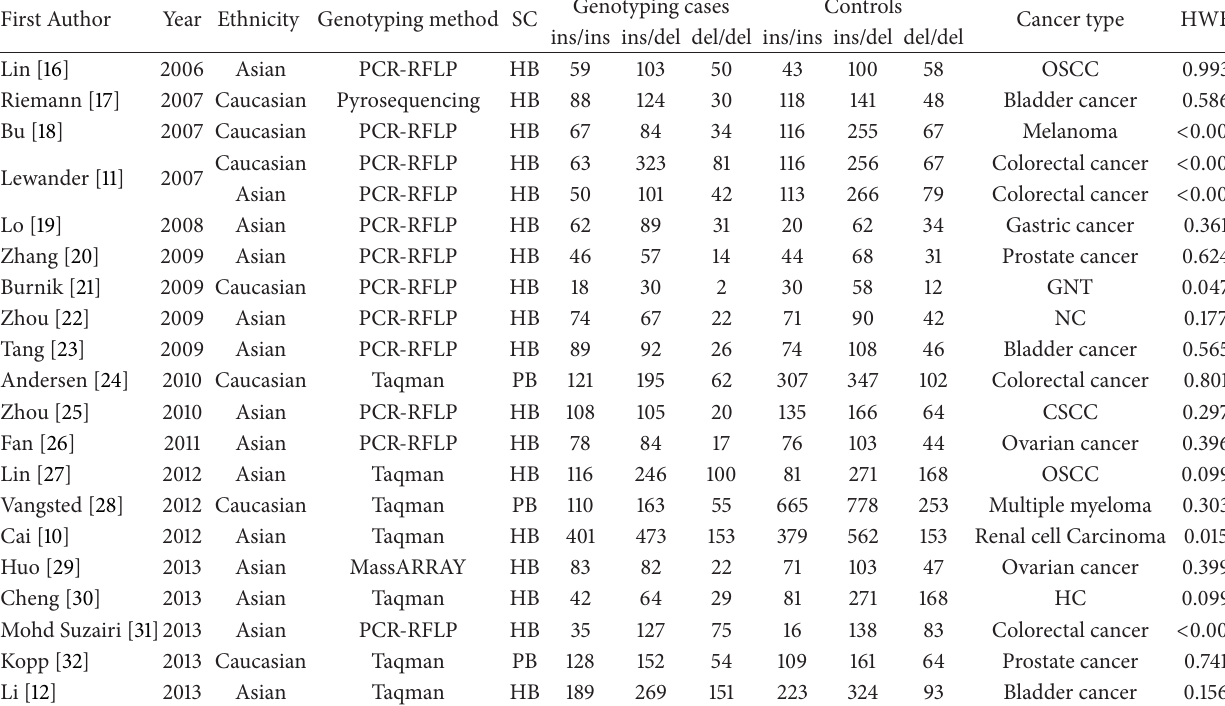
Table 1: Main characteristics of these studies included in this